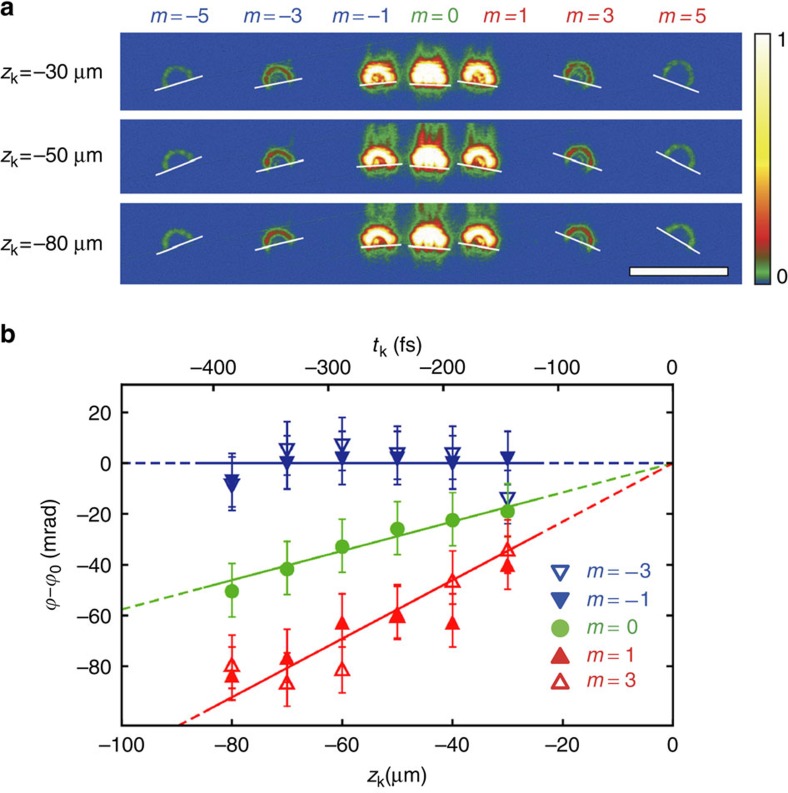
Experimental images of the cut vortex beams and their m-dependent rotations with the propagation distance.(a) Experimental images of the row of the cut vortex beams with different m at different positions of the knife edge, zk (Fig. 2). The scale bar is 50 nm. The opposite inclination of the opposite-m states is because of the residual Gouy-phase diffraction effect4647. At the same time, one can see a slow rotation of the m>0 modes with zk, while the m<0 states remain motionless. A quantitative analysis of these m-dependent rotations is depicted in b. The azimuthal orientations of the cut modes ϕ (with respect to the extrapolated reference azimuth ) are plotted versus zk and the corresponding timescale tk=zk/v (on the top). Three lines correspond to the zero, Larmor and cyclotron rotations predicted for the Landau states in equation (4). Error bars include the uncertainty in reading, knife-edge roughness and stage positioning.